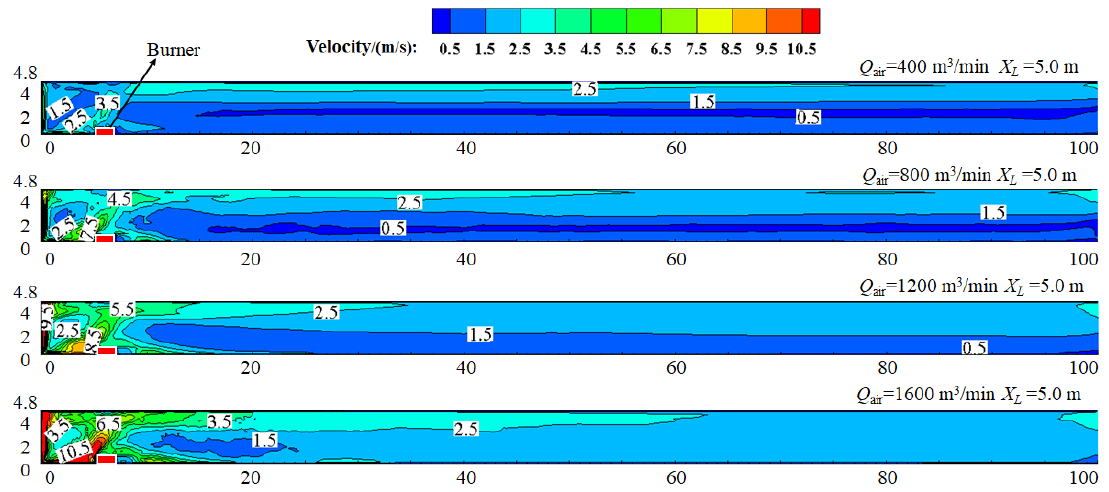
Figure 11. The flow field distribution at the height Z = 1.6 m. ( Q air = 1600 m 3 /min, X L = 20.0 m).